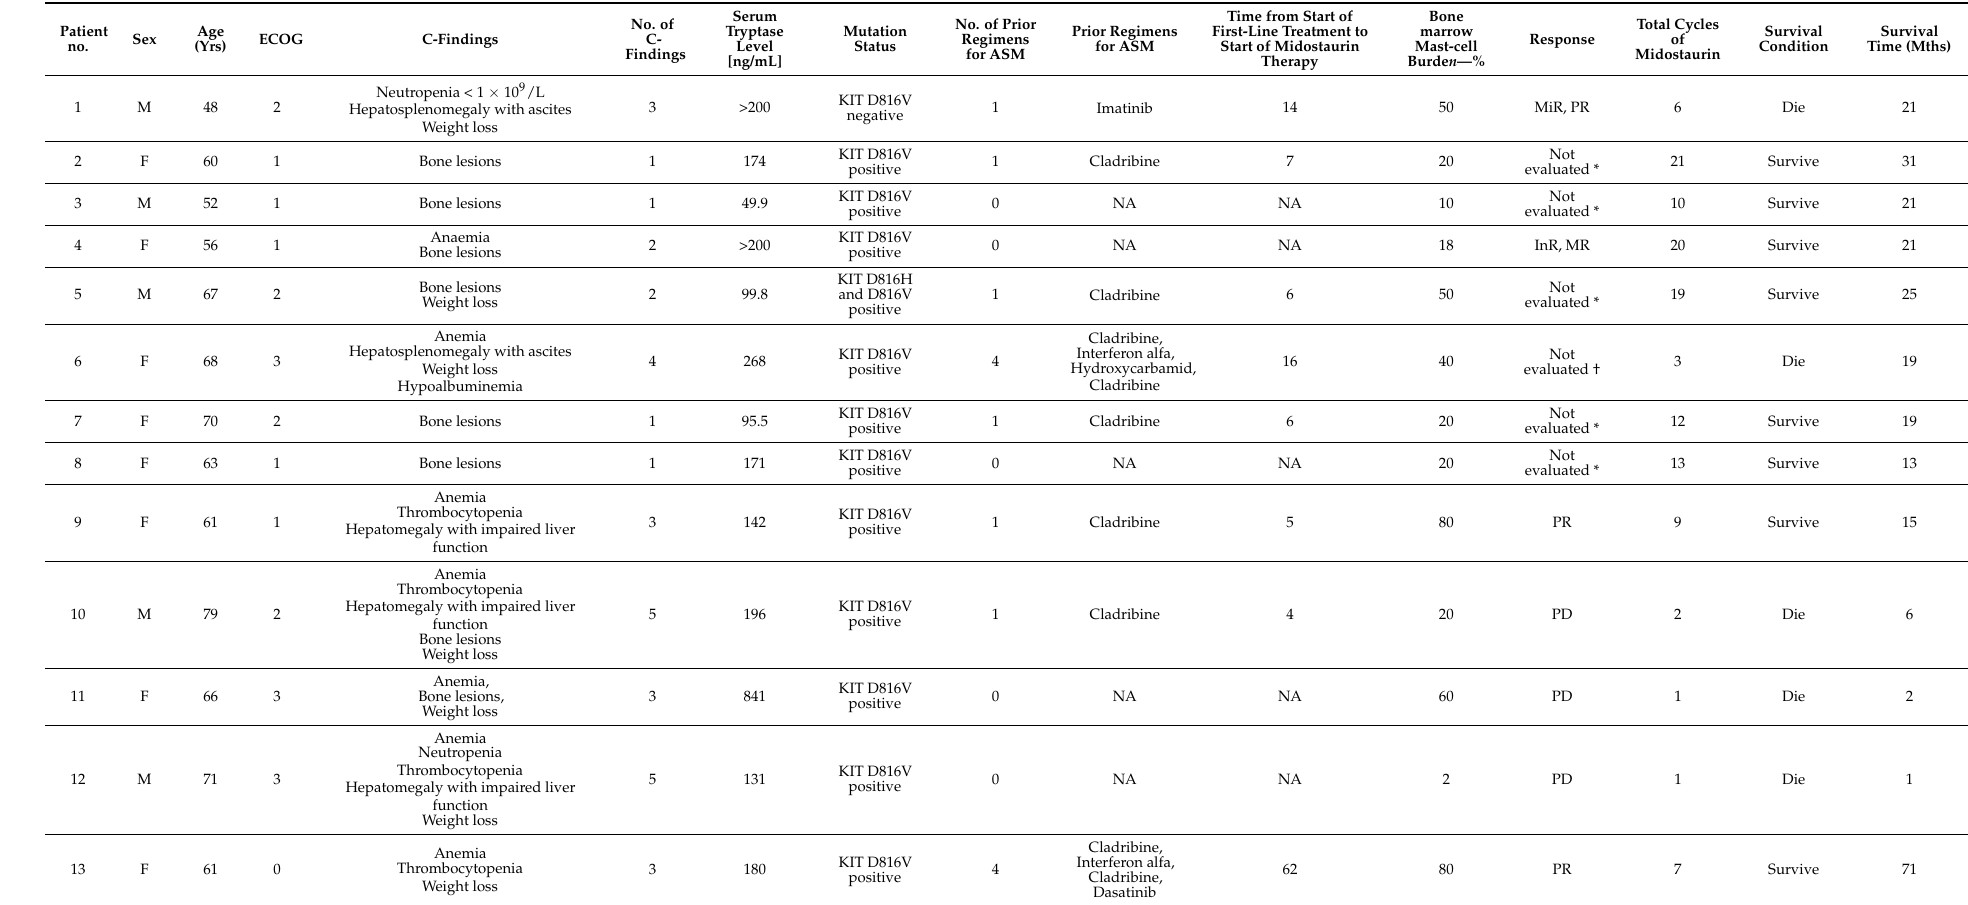
Table 2. Clinical diagnosis and outcomes in